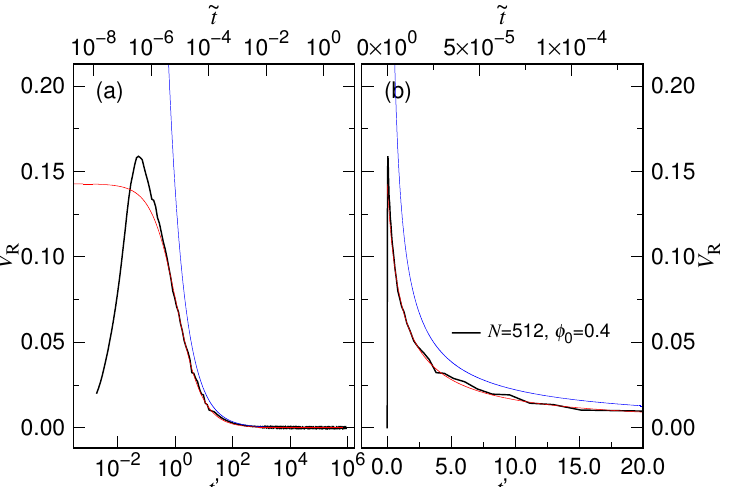
Figure 17. Expansion velocity V R vs. scaled time t (cid:48) = t / τ s for N = 512 with φ 0 = 0.4, plotted in ( a ) logarithmic scale and ( b ) linear scale. The simulation curve is drawn in black color, the velocity calculated from Equation (14) in red color, and the velocity calculated from Equation (15) in blue color. The process described by the scaled time ˜ t = t / τ c can be read on the top of the plots. How the maximum velocity V R,max varies with N and φ 0 is presented in Figure 18.